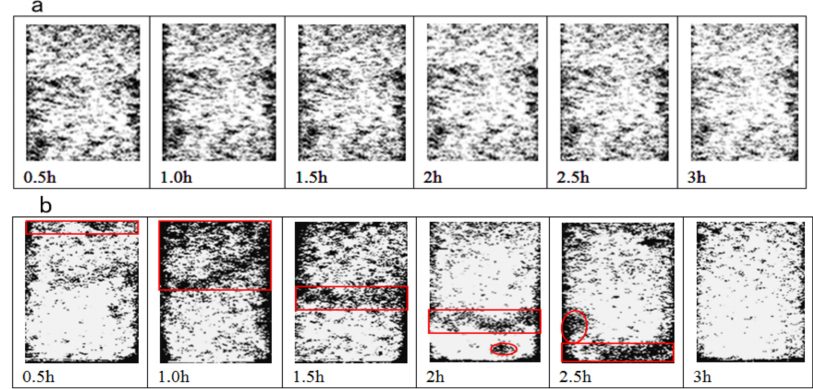
Figure 4. Inversion images between samples leached with DI water ( a ) and (NH 4 ) 2 SO 4 solution ( b ) during the leaching period. The black areas in the image represent solid matter, and the white areas represent pores.